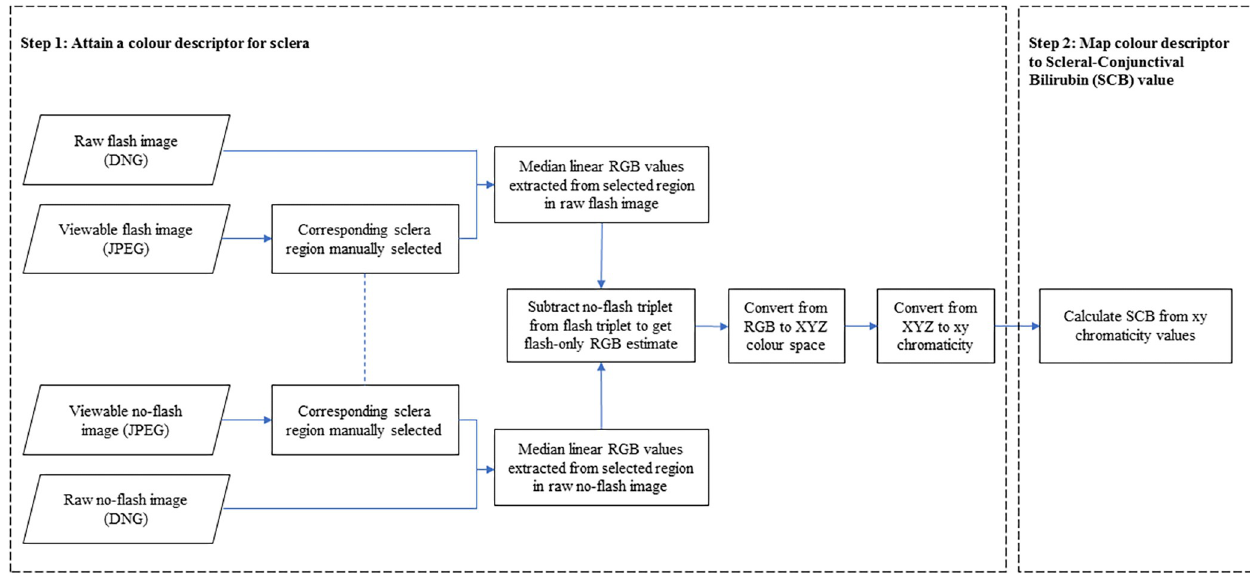
Fig 2. Processing pipeline to estimate scleral-conjunctival bilirubin from raw format flash/ no-flash image pairs. In Step 1, a color descriptor is estimated (ambient-subtracted sclera chromaticity). In Step 2, this is mapped to a scleral-conjunctival bilirubin (SCB) value.